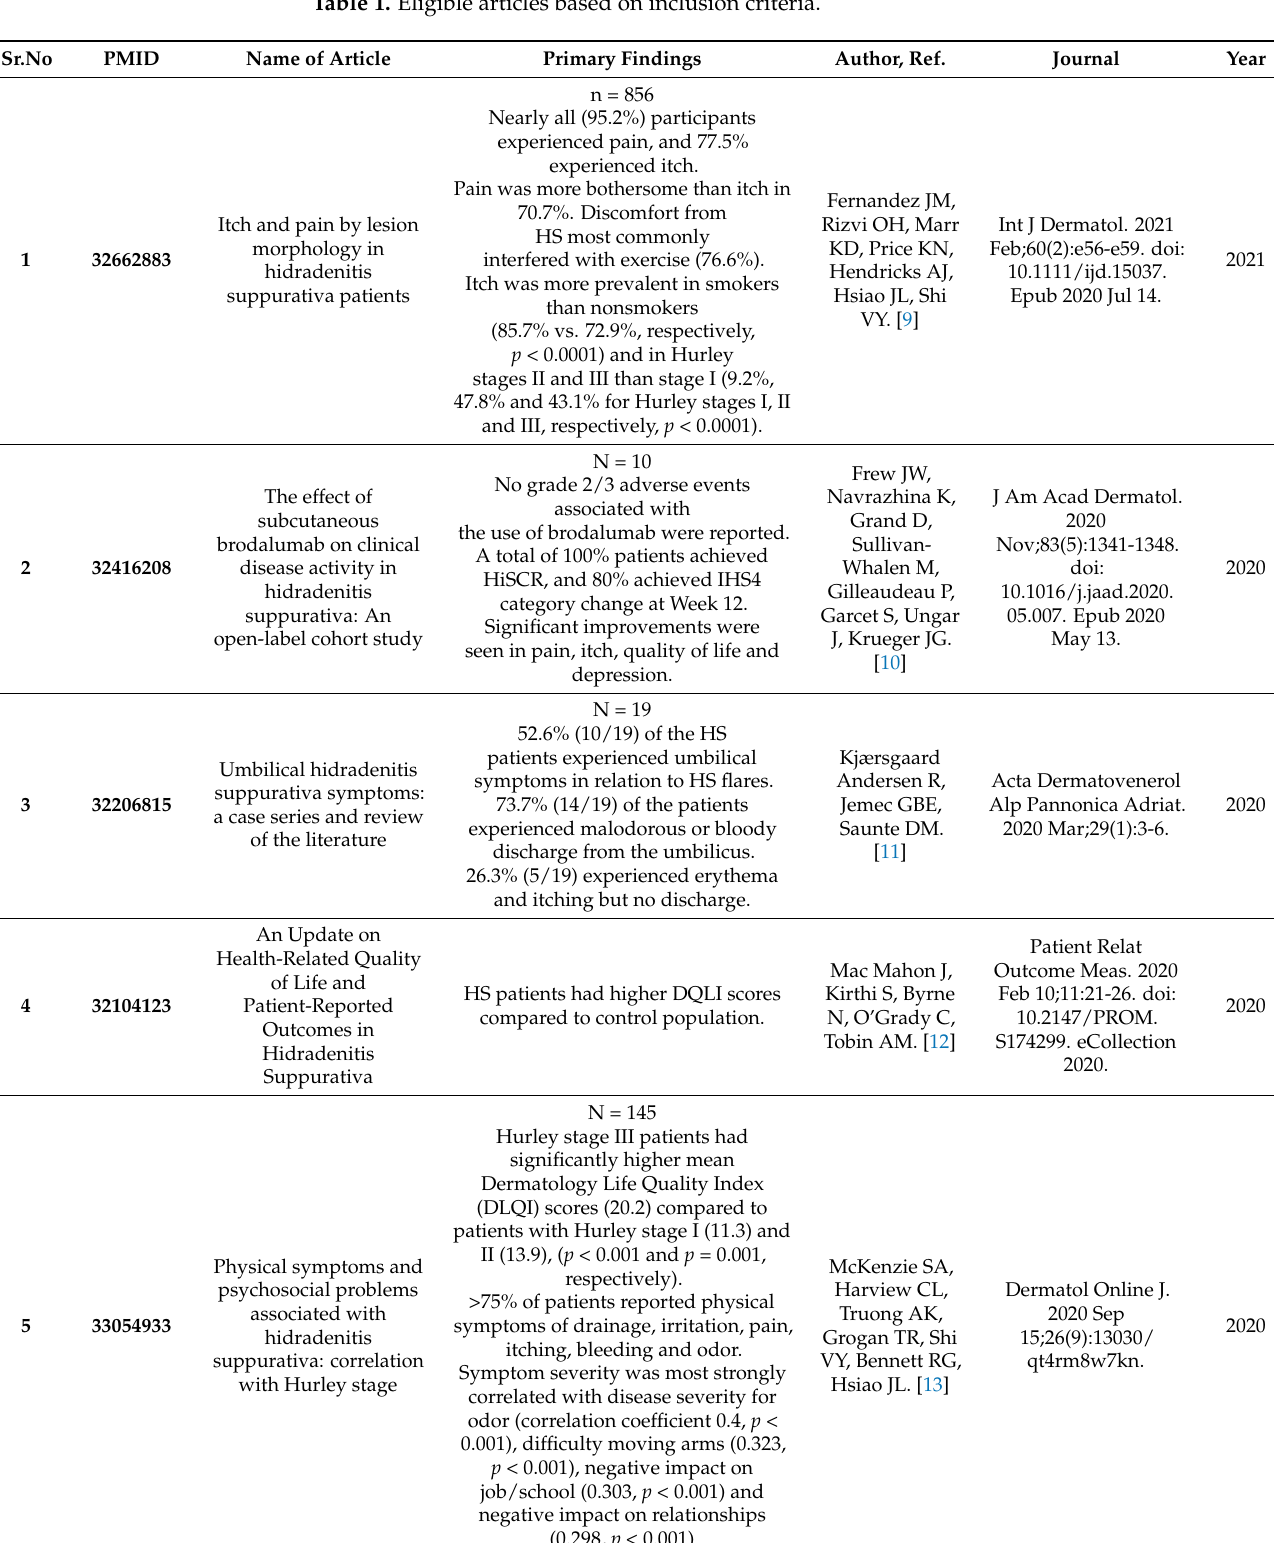
Table 1. Eligible articles based on inclusion